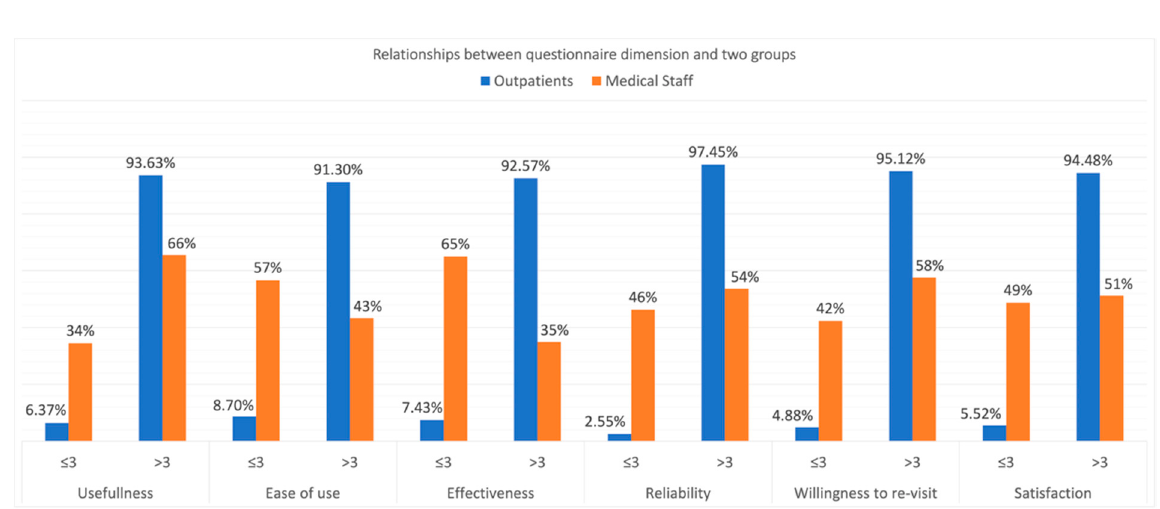
Figure 1. Relationships between the questionnaire dimension and two groups. There is no significant difference in the analysis of variances in each dimension in the medical staff group, except for the respondent identity in dimension 3 (effectiveness). In the outpatient group, gender is a significant variable in the six dimensions (Table 4). In the multiple regression, gender is still a significant variable in the six dimensions among the outpatient group. We also used the variance-inflation factors for detecting multicol- linearity. Table 4. Analysis of variance for respondents’ identity, gender, age, education, and marriage. Dimension